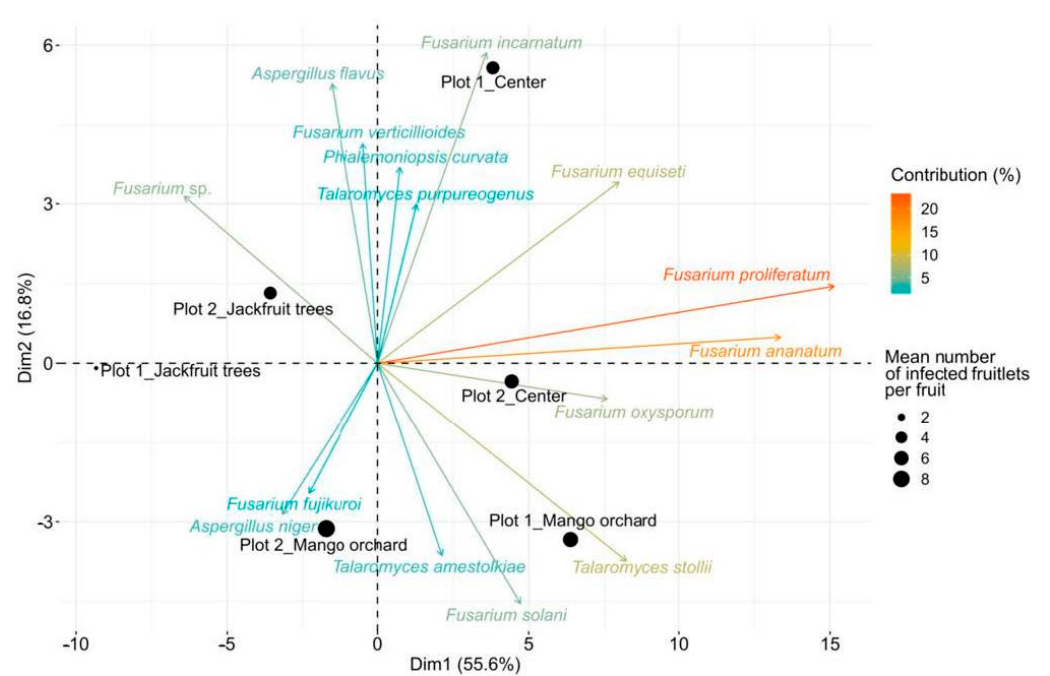
Figure 4. Principal component analysis (PCA) of combinations between proximal crop and plot direction. Only the 15 most contributory fungal species are shown (contributions ranging from 23.60% to 1.08%). Plot 1: North-West/South-East-directed rows; Plot 2: South-West/North-East-directed rows; mango orchard or jackfruit trees as adjacent crops, respectively; center: No adjacent crops. The size of each dot is proportional to the average number of infected fruitlets per fruit for each section of plots.